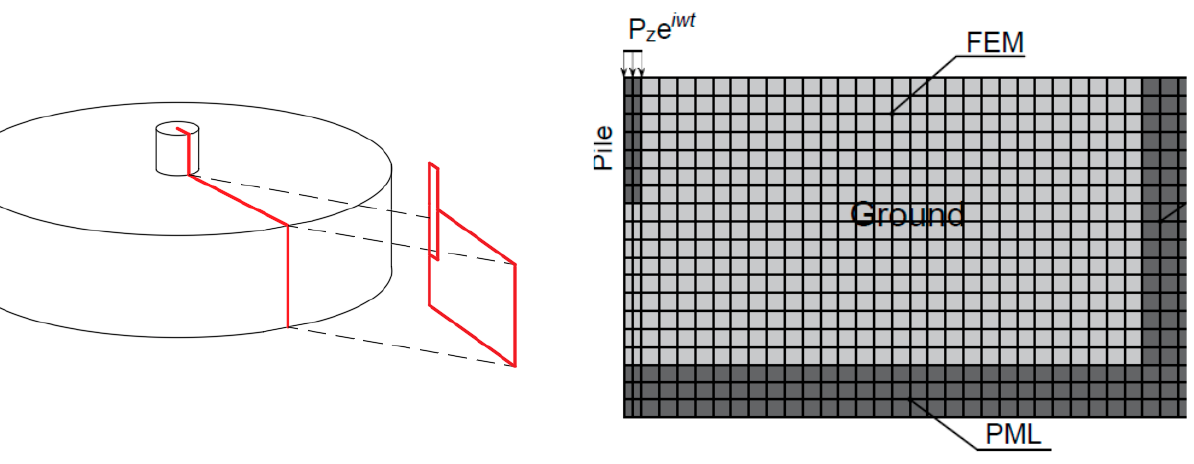
Figure 2. Pile–ground system model using an axisymmetric FEM-PML numerical approach.